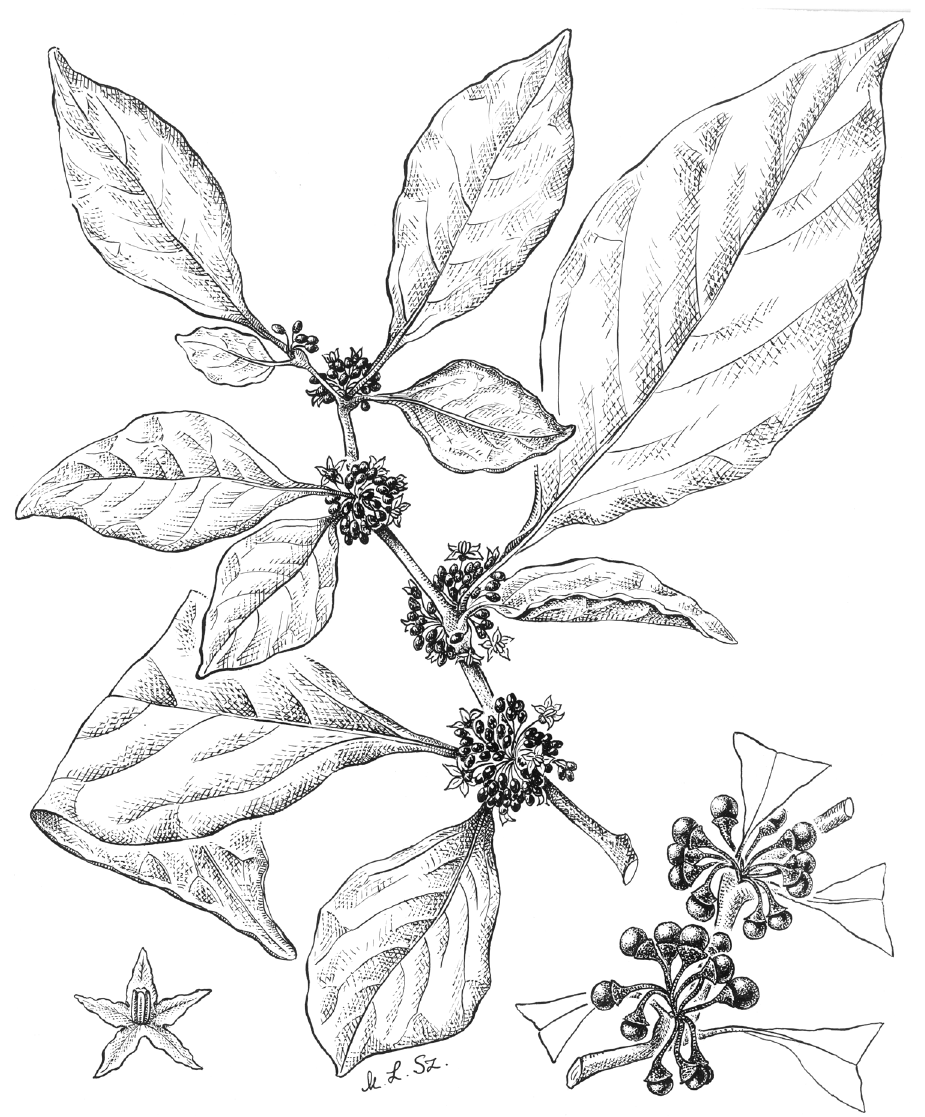
Figure 37. Lycianthes oliveriana (Lauterb. & K.Schum.) Bitter. Drawing by M.L. Szent-Ivany, first pub- lished in Symon (1985: fig. 17, as S. oliverianum Lauterb. & K.Schum.). Courtesy of the Board of the Botanic Gardens and State Herbarium (Adelaide, South Australia), reproduced with